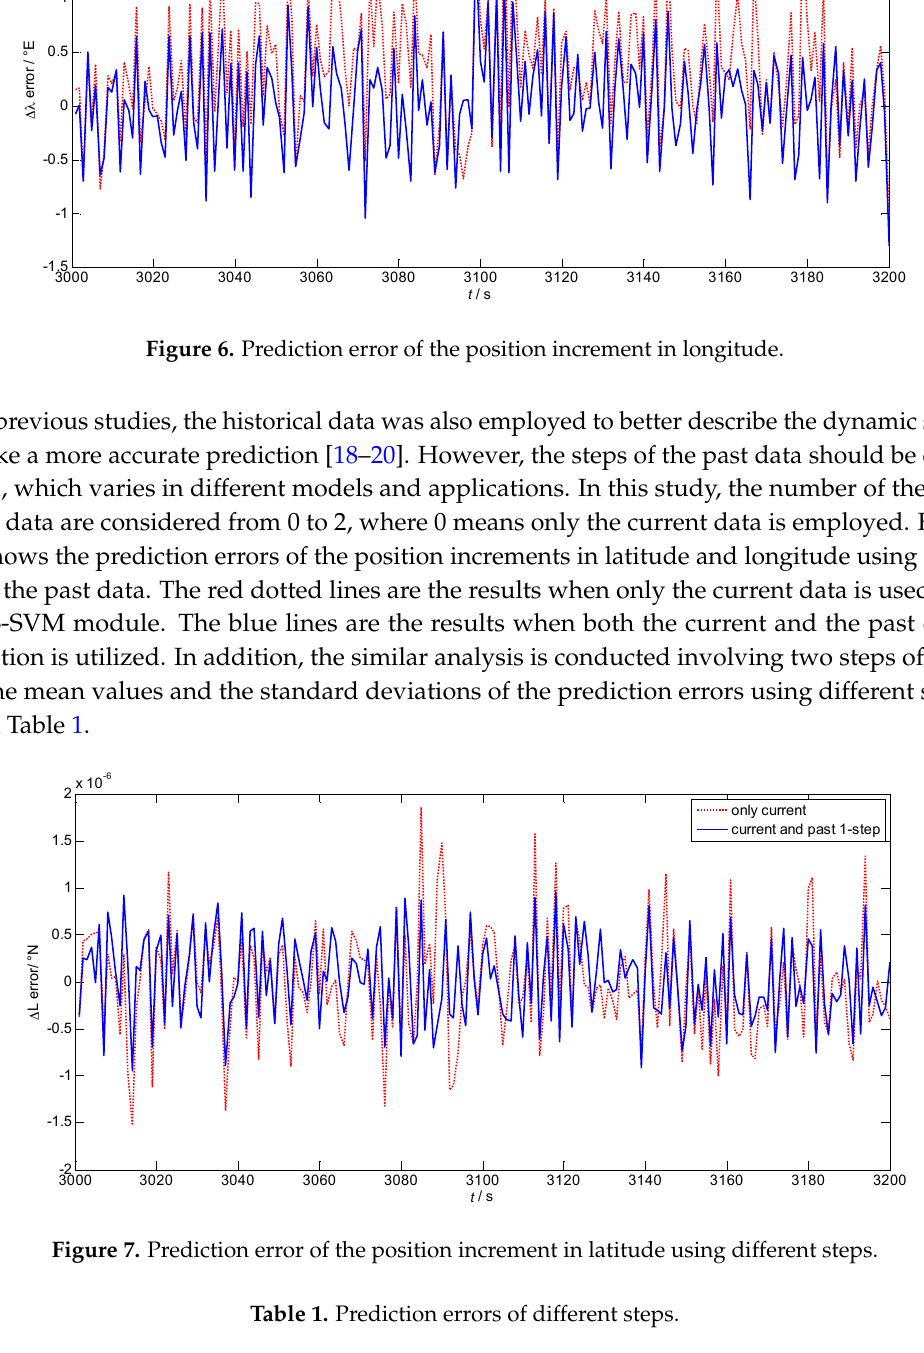
Figure 5. Prediction error of the position increment in latitude.